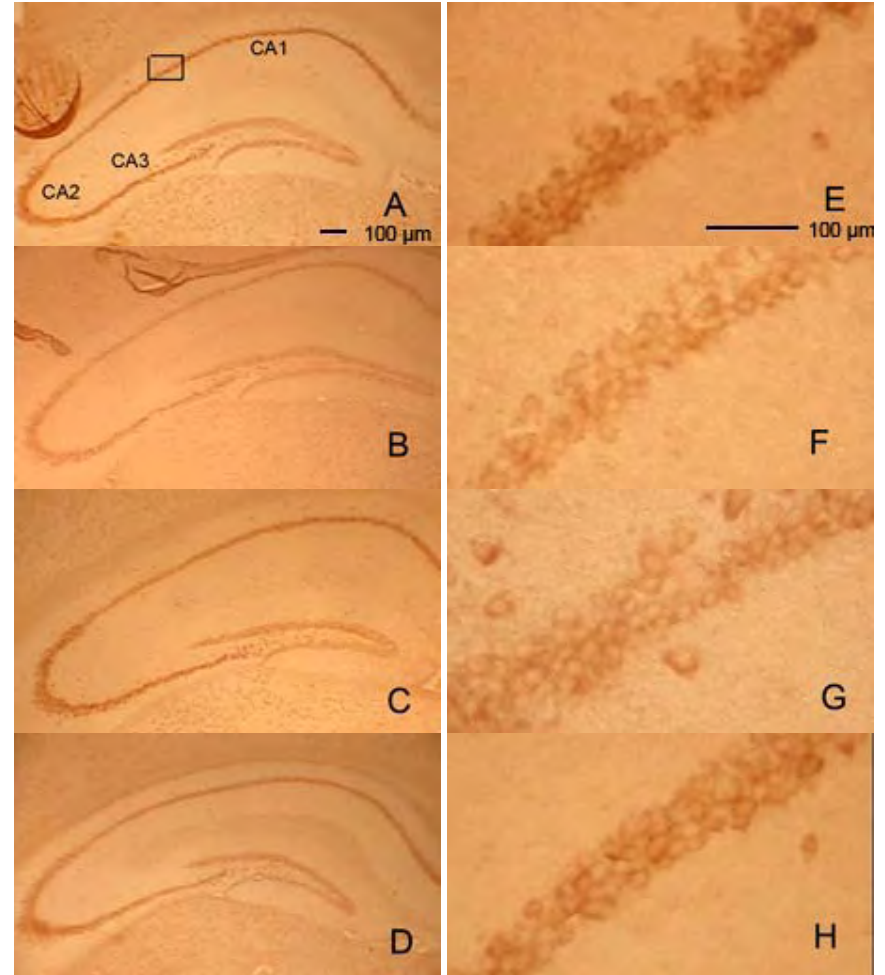
Figure 6 . Effects of daidzein on the expression levels of caspase-3 in D-gal-treated mice hippocampus. (A) Aging control. (B) Vehicle control. (C) Da-10 group. (D) Da-5 group.